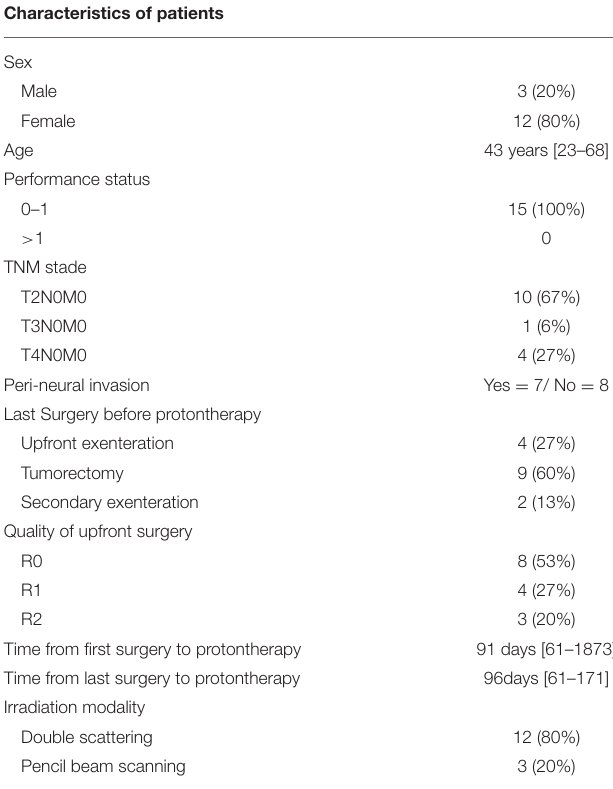
TABLE 1 | Characteristics of patients included in the study at